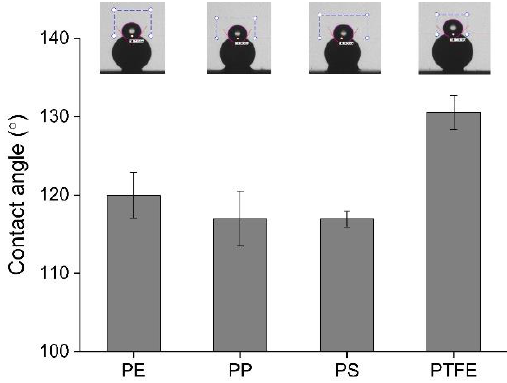
Figure 1. Contact angle measurement of microplastics.